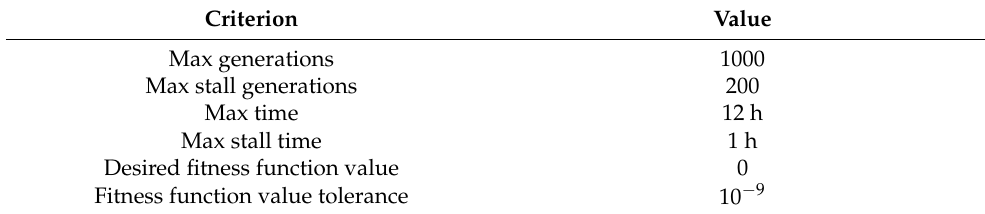
Table 5. Settings for stopping criteria of optimization.